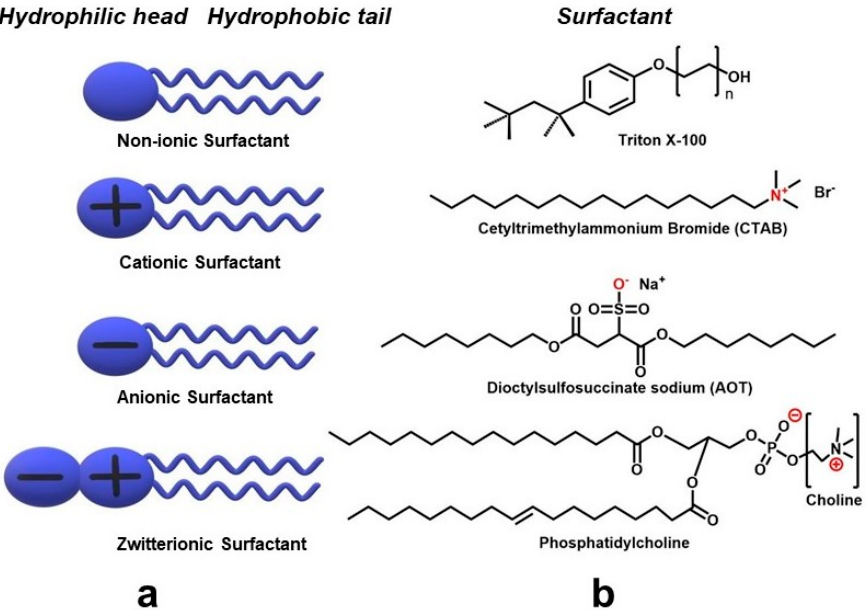
Figure 1. ( a ) A schematic of different type of surfactants and ( b ) Chemical structures of some common surfactants that have been used in a microemulsion synthesis of nanoparticles (NPs).